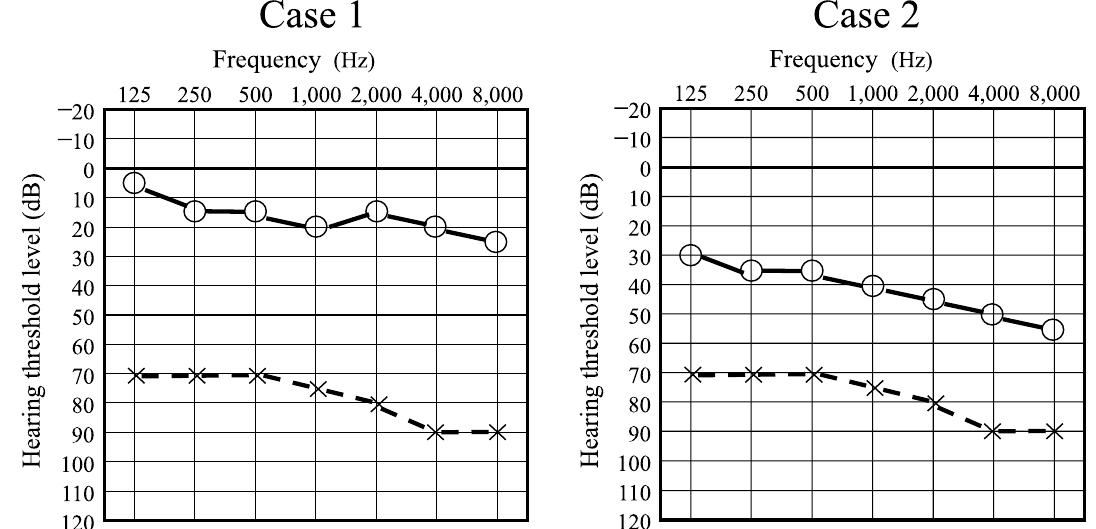
Figure 1. Two hypothetical cases showing two different patterns of idiopathic sudden sensorineural hearing loss (ISSNHL) classified as having similar severity using current diagnostic criteria. In Case 1, hearing threshold levels on healthy side are almost in the normal range. In Case 2, hearing threshold levels on healthy side are in the range of mild to moderate hearing loss. x symbols and dashed lines indicate threshold values on the left (affected) side; open circles and solid lines indicate threshold values on the right (healthy)